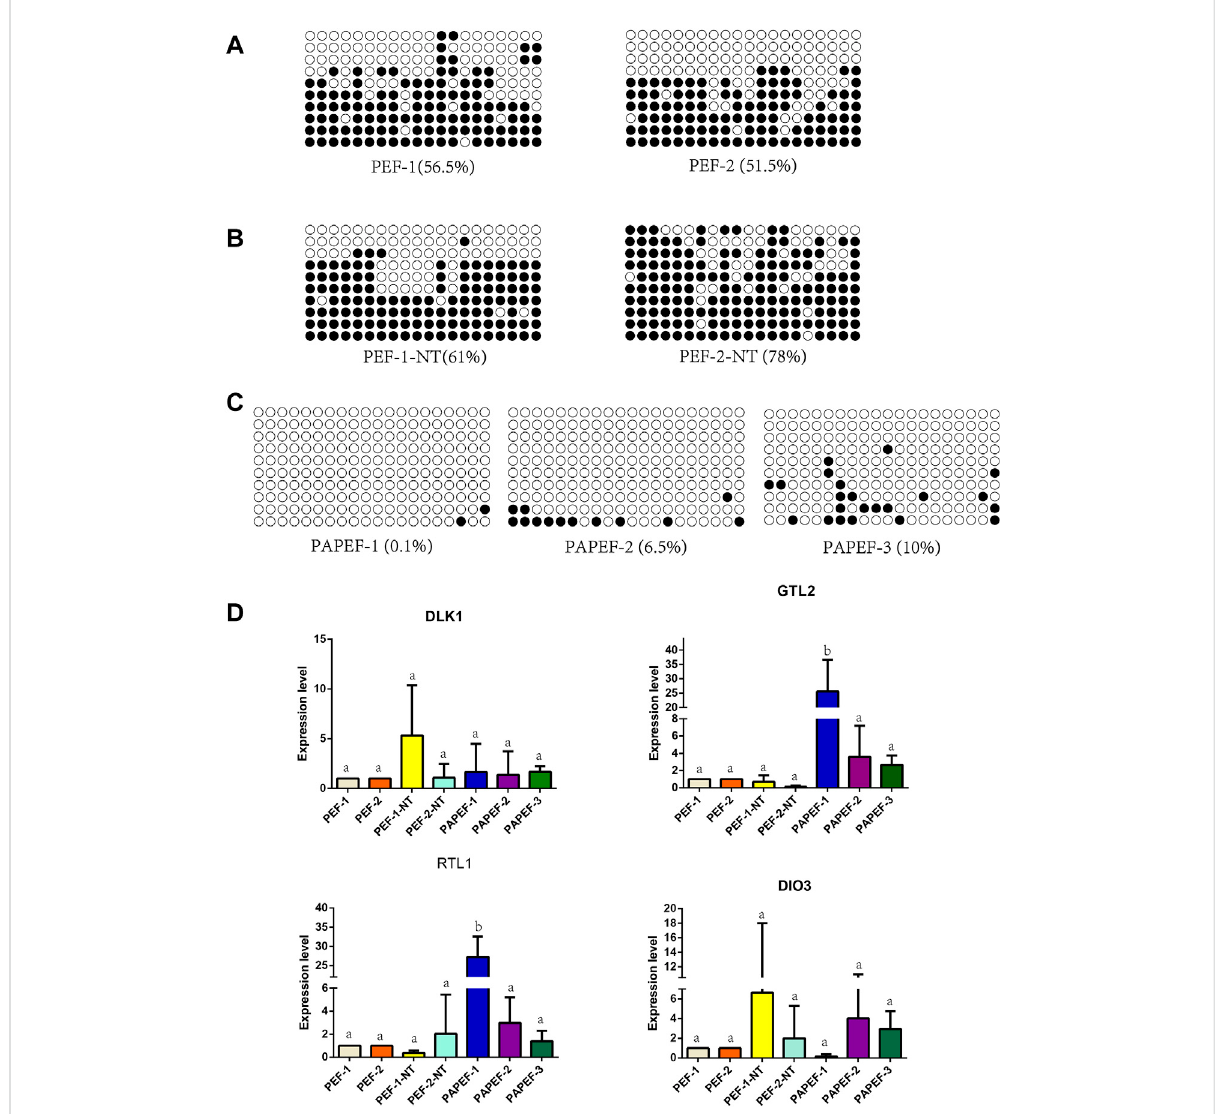
FIGURE 4 Methylation analysis of IG-DMR gene imprinting expression of the DLK1-DIO3 region in pEF, NTpEF, and PApEF. (A) Analysis of IG-DMR methylation levels in pEF, (B) NTpEF, and (C) PApEF. Each circle represents one CpG dinucleotide. The degree of methylation (%) is based on methylated CPGs/all CPGs; open circles indicate unmethylated CpGs, and fi lled circles indicate methylated CpGs. (D) Analysis of DLK1 , GTL2 , RTL1 , and DIO3 gene expression in pEF, NTpEF, and PApEF. Horizontal coordinates are samples, and vertical coordinates are gene expression levels. Different letters (A,B) indicate signi fi cant differences ( p <